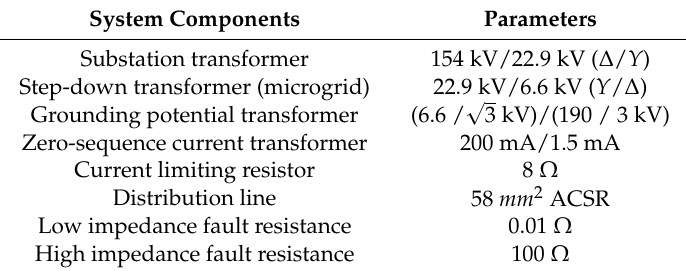
Figure 13. The Power System Computer Aided Design (PSCAD)/Electromagnetic Transients including DC (EMTDC) model of the low ‐ inertia microgrid. Table 2. Distribution line